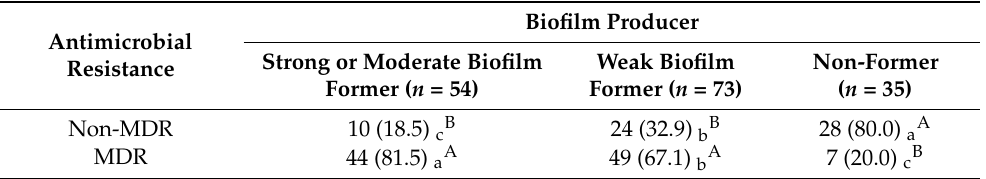
Table 2. Relationship between biofilm-associated genes and biofilm-forming ability in 162 coagulase negative staphylococci from milk.